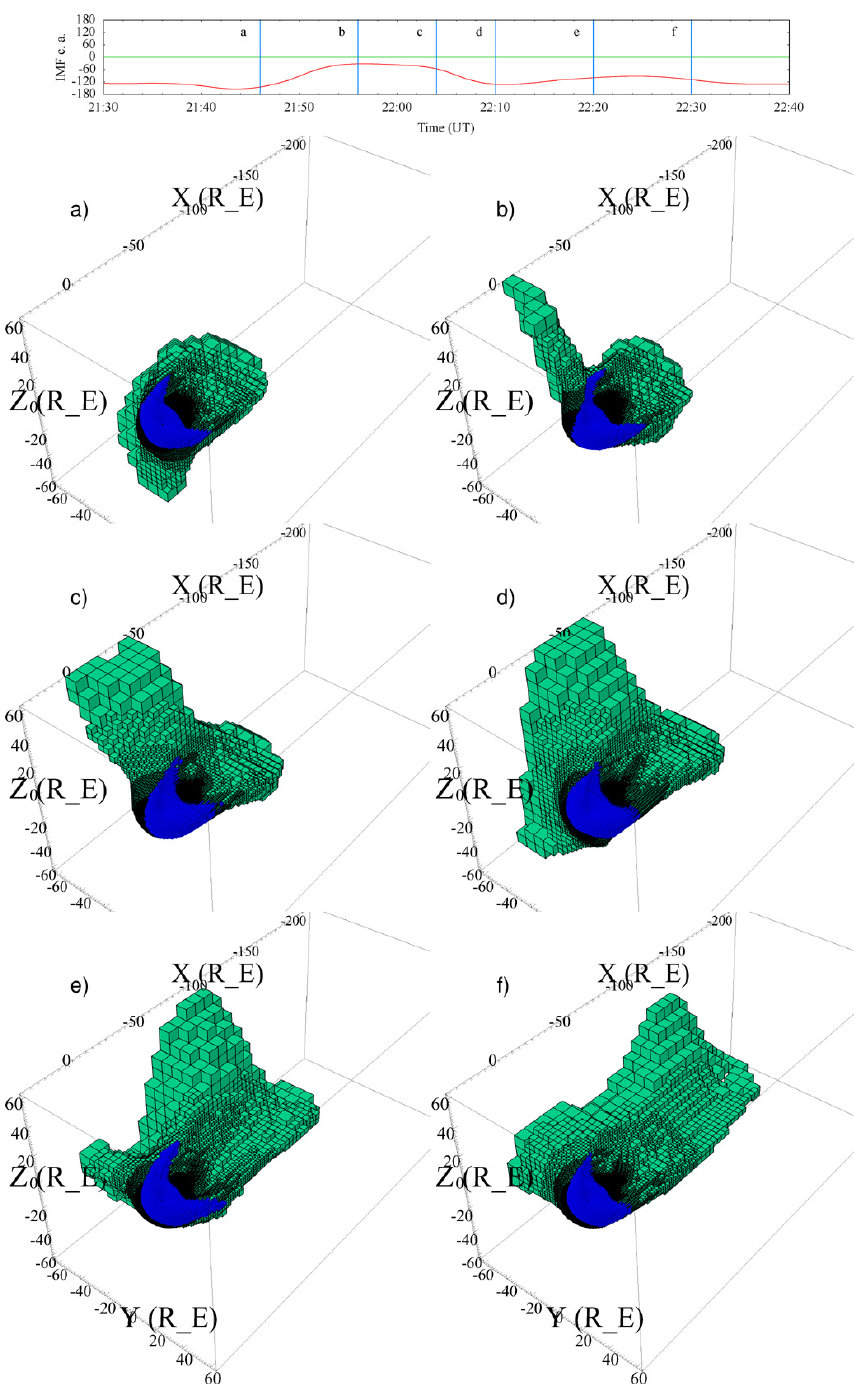
Fig. 10. Classification of cells in the simulation by their magnetic field topology is shown in the same format as in Fig. 8. The magnetic field topology and clock angle in the simulation are shown during and after the third AE intencification at (a) 21:46, (b) 21:56, (c) 22:04, (d) 22:10, (e) 22:20 and (f)